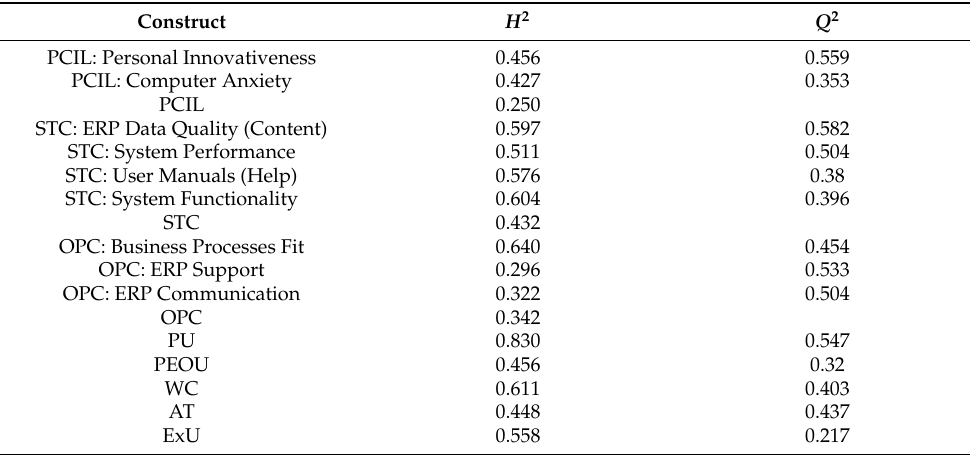
Table 8. cv-redundancy ( Q 2 ) and cv-communality ( H 2 ) indices.